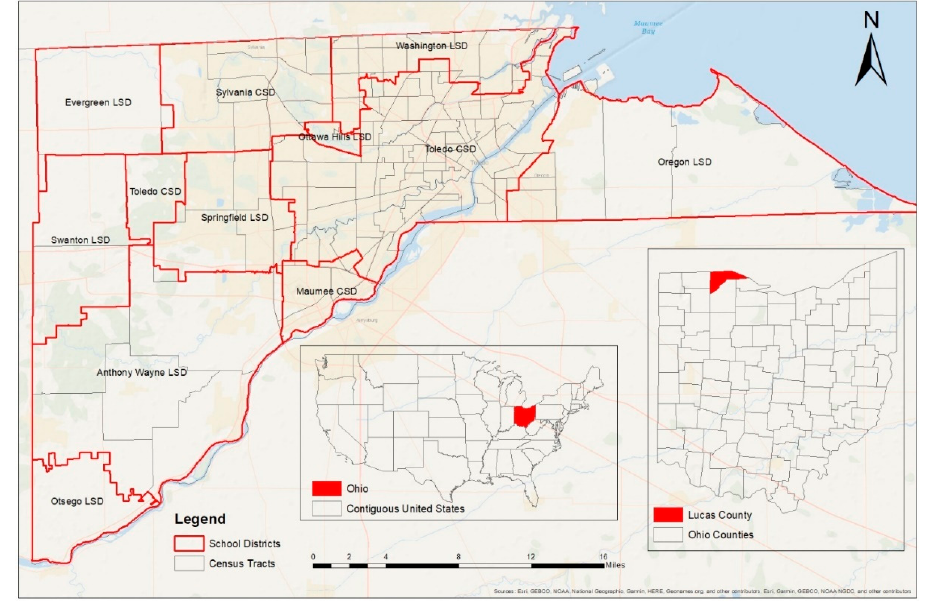
Figure 1. Census tracts and school districts in Lucas County, Ohio.